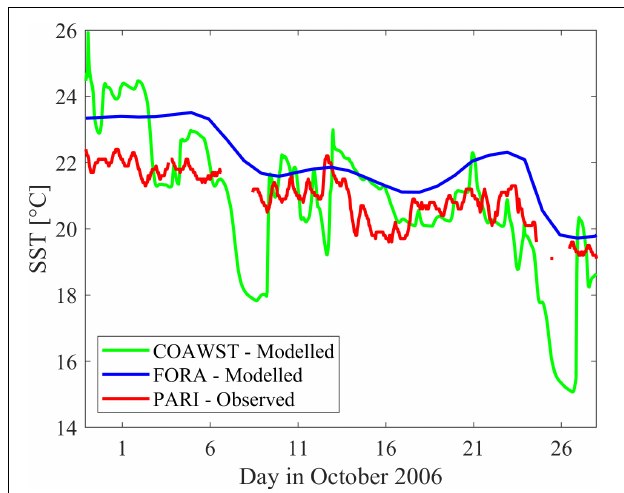
FIGURE 6 | Comparison of time series of Sea Surface Temperature among modeled and observed data in Hasaki (green: COAWST model, blue: FORA model, red: PARI observed